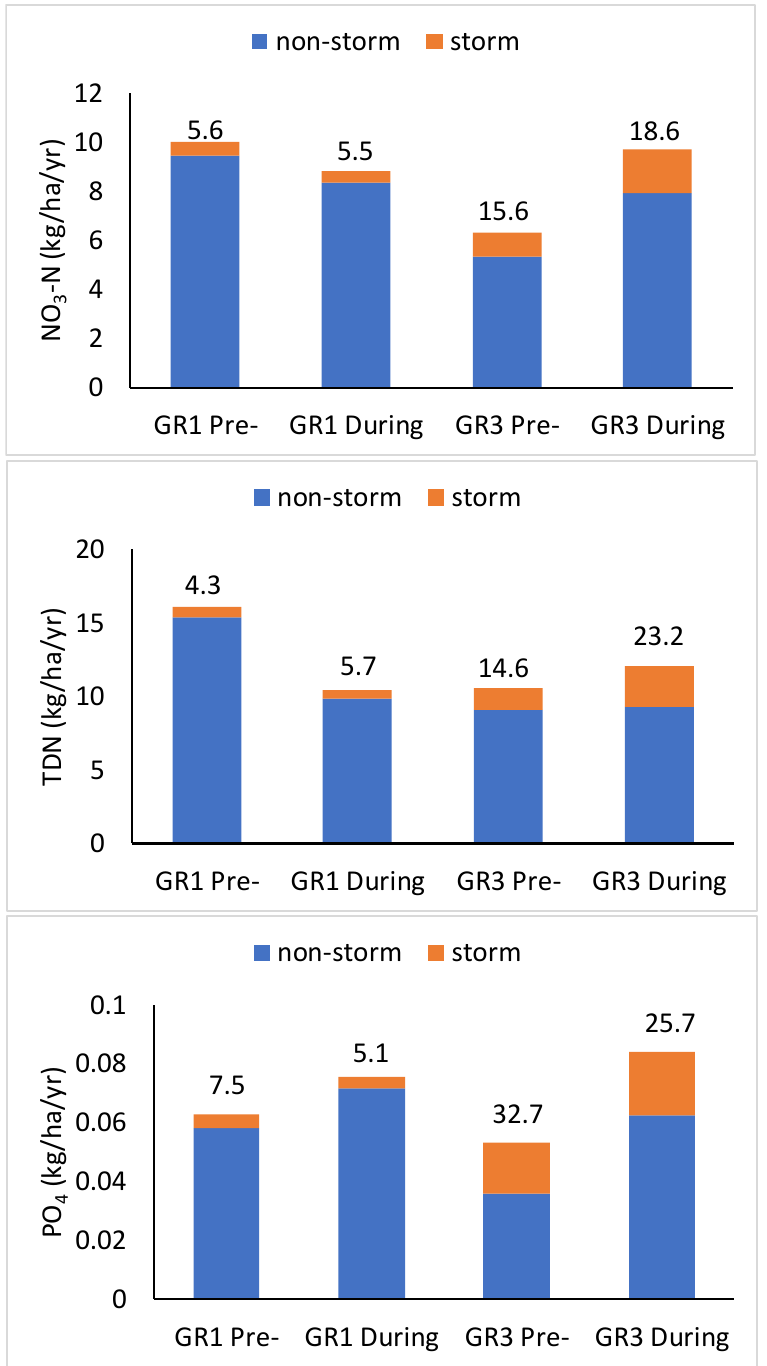
Figure 9. Stream water nutrient fluxes pre- and during restoration at the upstream (GR1) and downstream (GR3) sites for nitrate-N (NO 3 -N), TDN, and ortho-P (PO4). Non-storm and storm values are reported with the % storm contributions listed above the bars. Storm event contributions were greater at the downstream site. Table 2. Monthly nutrient flux means with one standard deviation. ANOVA p -values are listed for